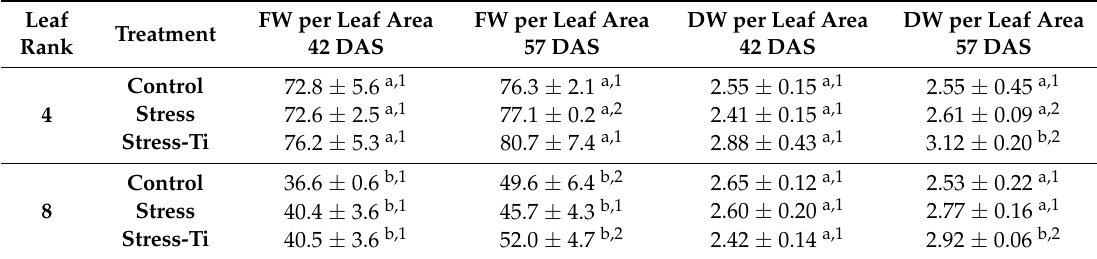
Table 2. Fresh Weight per leaf area (FW) and Dry Weight per leaf area (DW) of the LR4 and LR8 at two stages and for different treatments. Different letters means statistical differences ( p < 0.05) between treatments or leaf ranks and different numbers means statistical differences ( p < 0.05) between stages for the same